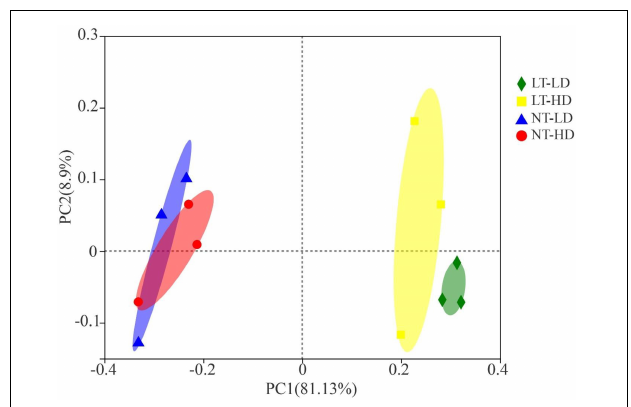
FIGURE 1 | Principal coordinates analysis of the bacterial community for sorghum-sudangrass silage ( R 2 = 0.8362, p = 0.003; n = 3). LT, storage temperature at 10 ◦ C; NT, storage temperature at 25 ◦ C; LD, ensiling density at 550 kg/m 3 ; HD, ensiling density at 650 kg/m 3 .